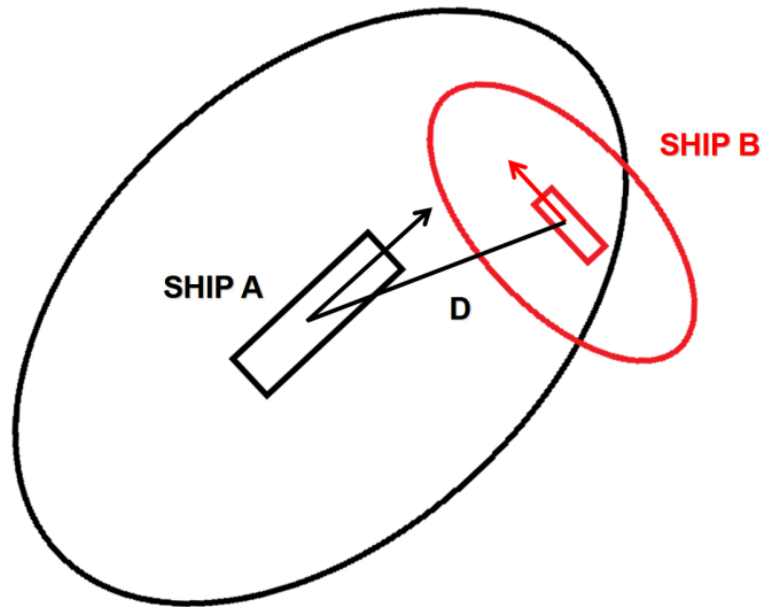
Figure 16. One-way conflict diagram.